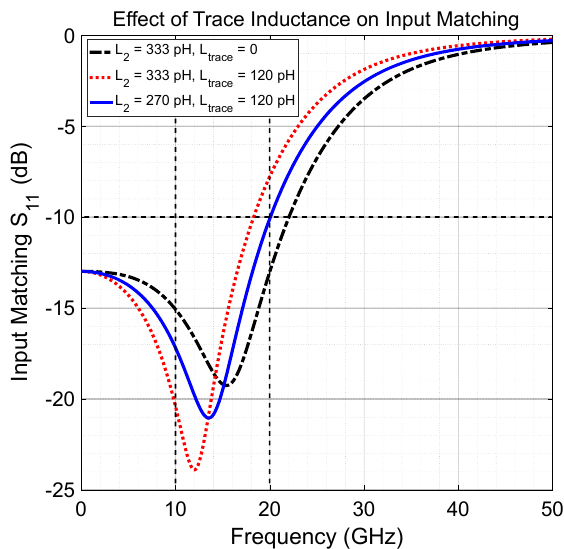
Figure 11. Effect of L trace on input